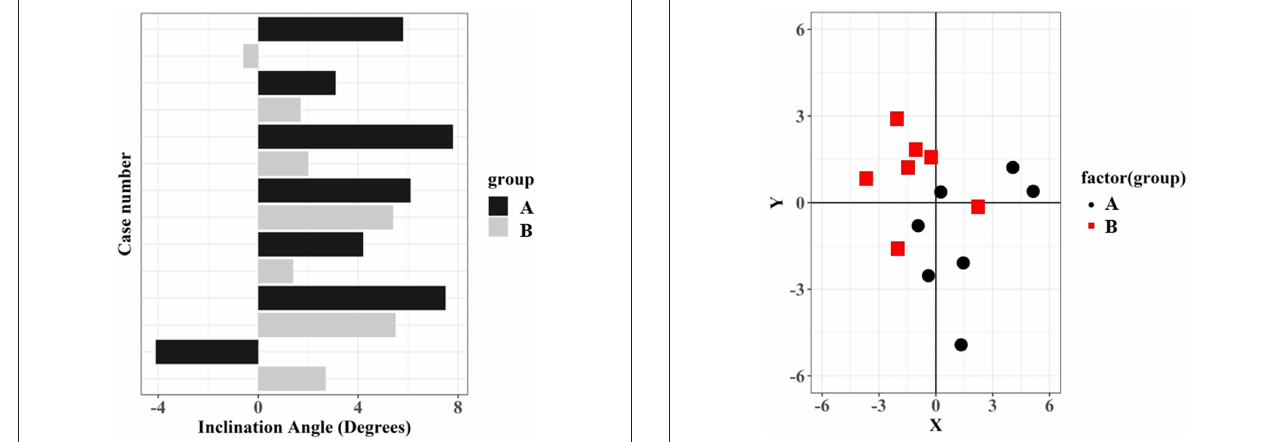
FIGURE 10 | Distance and direction of eccentricity for the two groups. The y-axis represents the tibial long axis, and the x-axis represents perpendicular to the tibial long axis. The intersection of the x-axis and y-axis is the intended center of the osteotomy, and each data point represents the center of actual